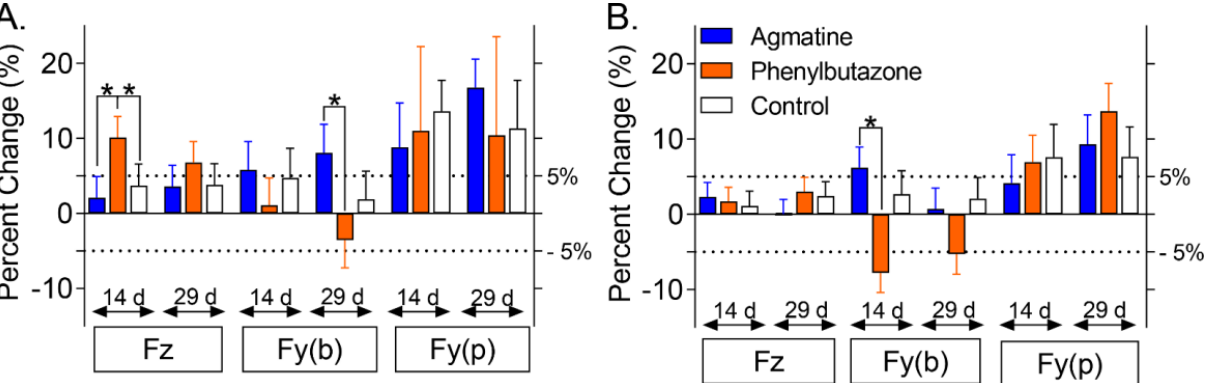
Figure 4. Percent change (LS mean ± SEM) in thoracic limb ground reaction forces over the baseline. Peak force ( A ) and impulse ( B ) in vertical (Fz) and craniocaudal braking (Fy(b)) and propulsion (Fy(p)) after 14 and 29 days of oral agmatine (blue), phenylbutazone (orange), or control (white) administration. Asterisks indicate differences among treatments within time points ( p < 0.05). A 5% change from the baseline (dotted lines) is indicated. Table 6. Fixed effects parameter estimates of peak force percent changes. Std Error: standard error; Prob > |t|: p -value; 95% Lower: 95% confidence interval lower limit; 95% Upper: 95% confidence interval upper limit.